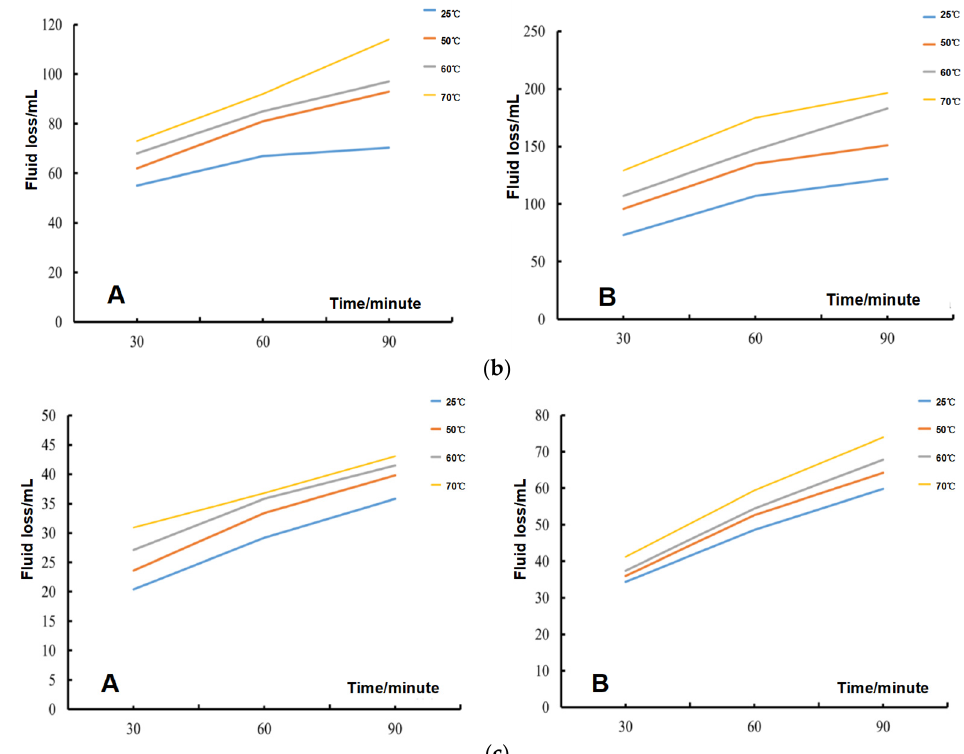
Figure 2. Fluid loss of bentonite with different test solutions at various temperatures (( a ), ( b ), and ( c ) are bentonite with deionized water, Xikuangshan, and Baojinshan, respectively; A, B refer to bentonite A and bentonite B, respectively).